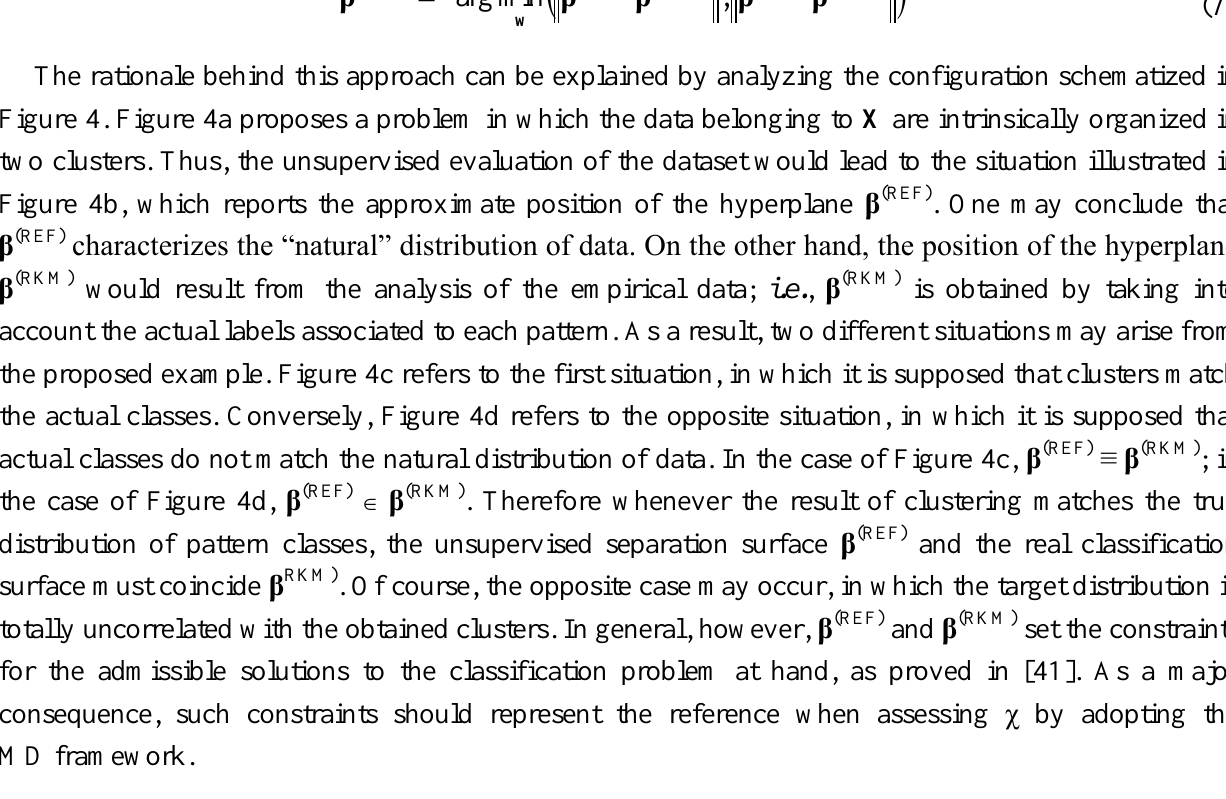
Figure 4. Difference between natural distribution of data and true distribution of